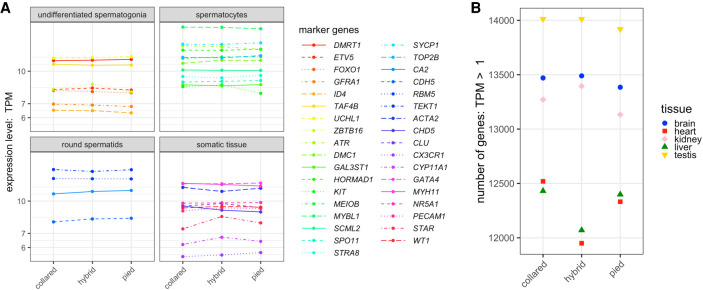
Transcription profile of the testis. (A) Gene expression levels (inTPM) of spermatogenesis cell-type marker genes categorized into four different stages—undifferentiated spermatogonia, spermatocytes, round spermatids, and testis niche cells—in testis of collared flycatcher, pied flycatcher, and their F1 hybrids. (B) Number of genes expressed at an expression level TPM > 1 for the five tissues, for collared flycatcher, pied flycatcher, and their F1 hybrids.